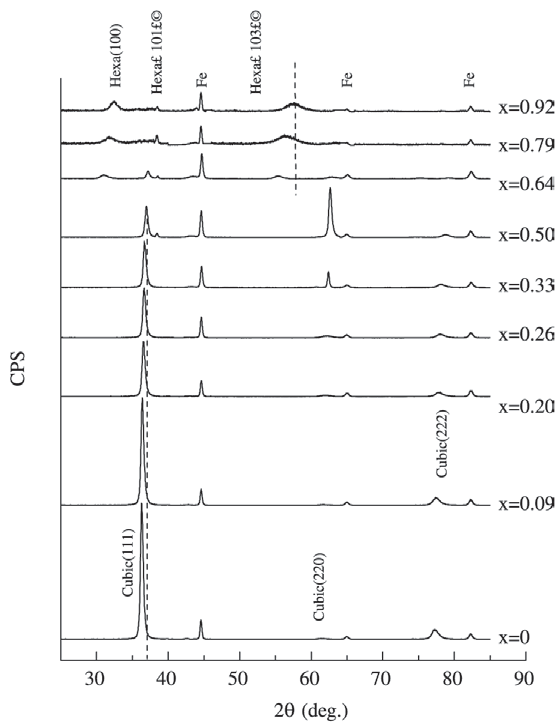
Figure1. XRD pattern of coatings (Ti, Al)N with different Al content.